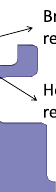
FIG. 13. Impedance match at outer radial line.